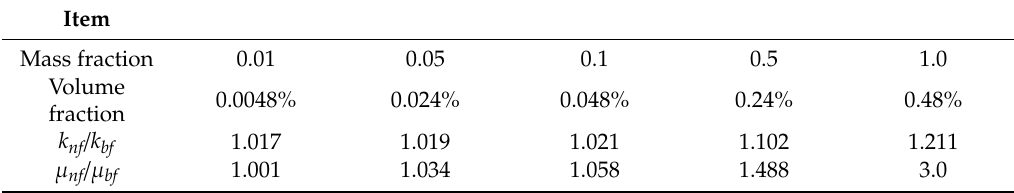
Table 3. Thermal properties of nanofluids compared to base